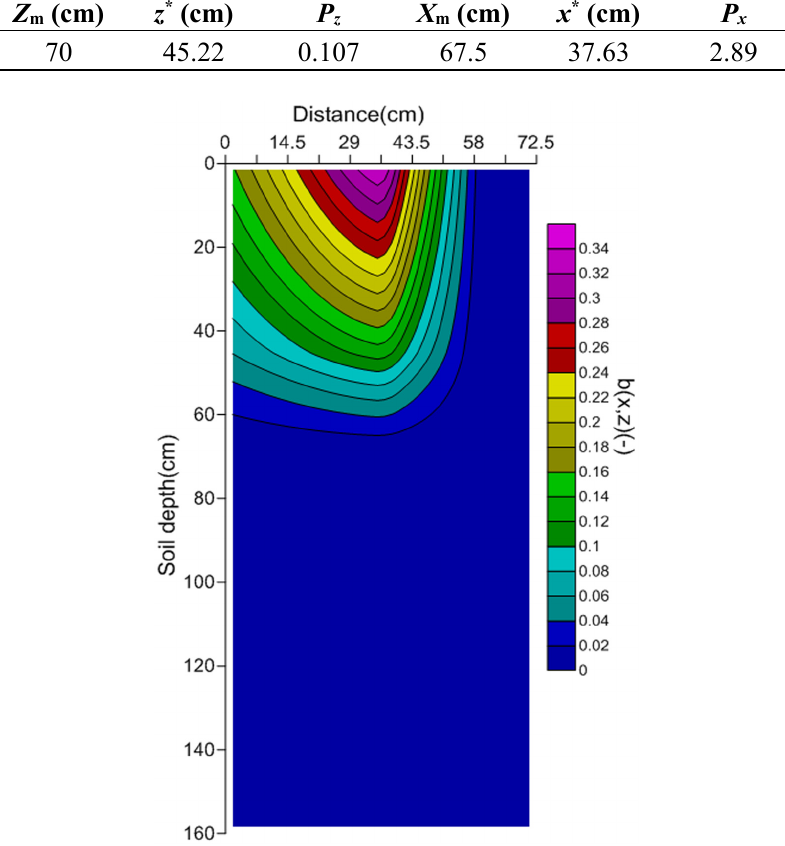
Figure 4. Root water uptake distribution function, i.e. , b ( x , z ) of Equation